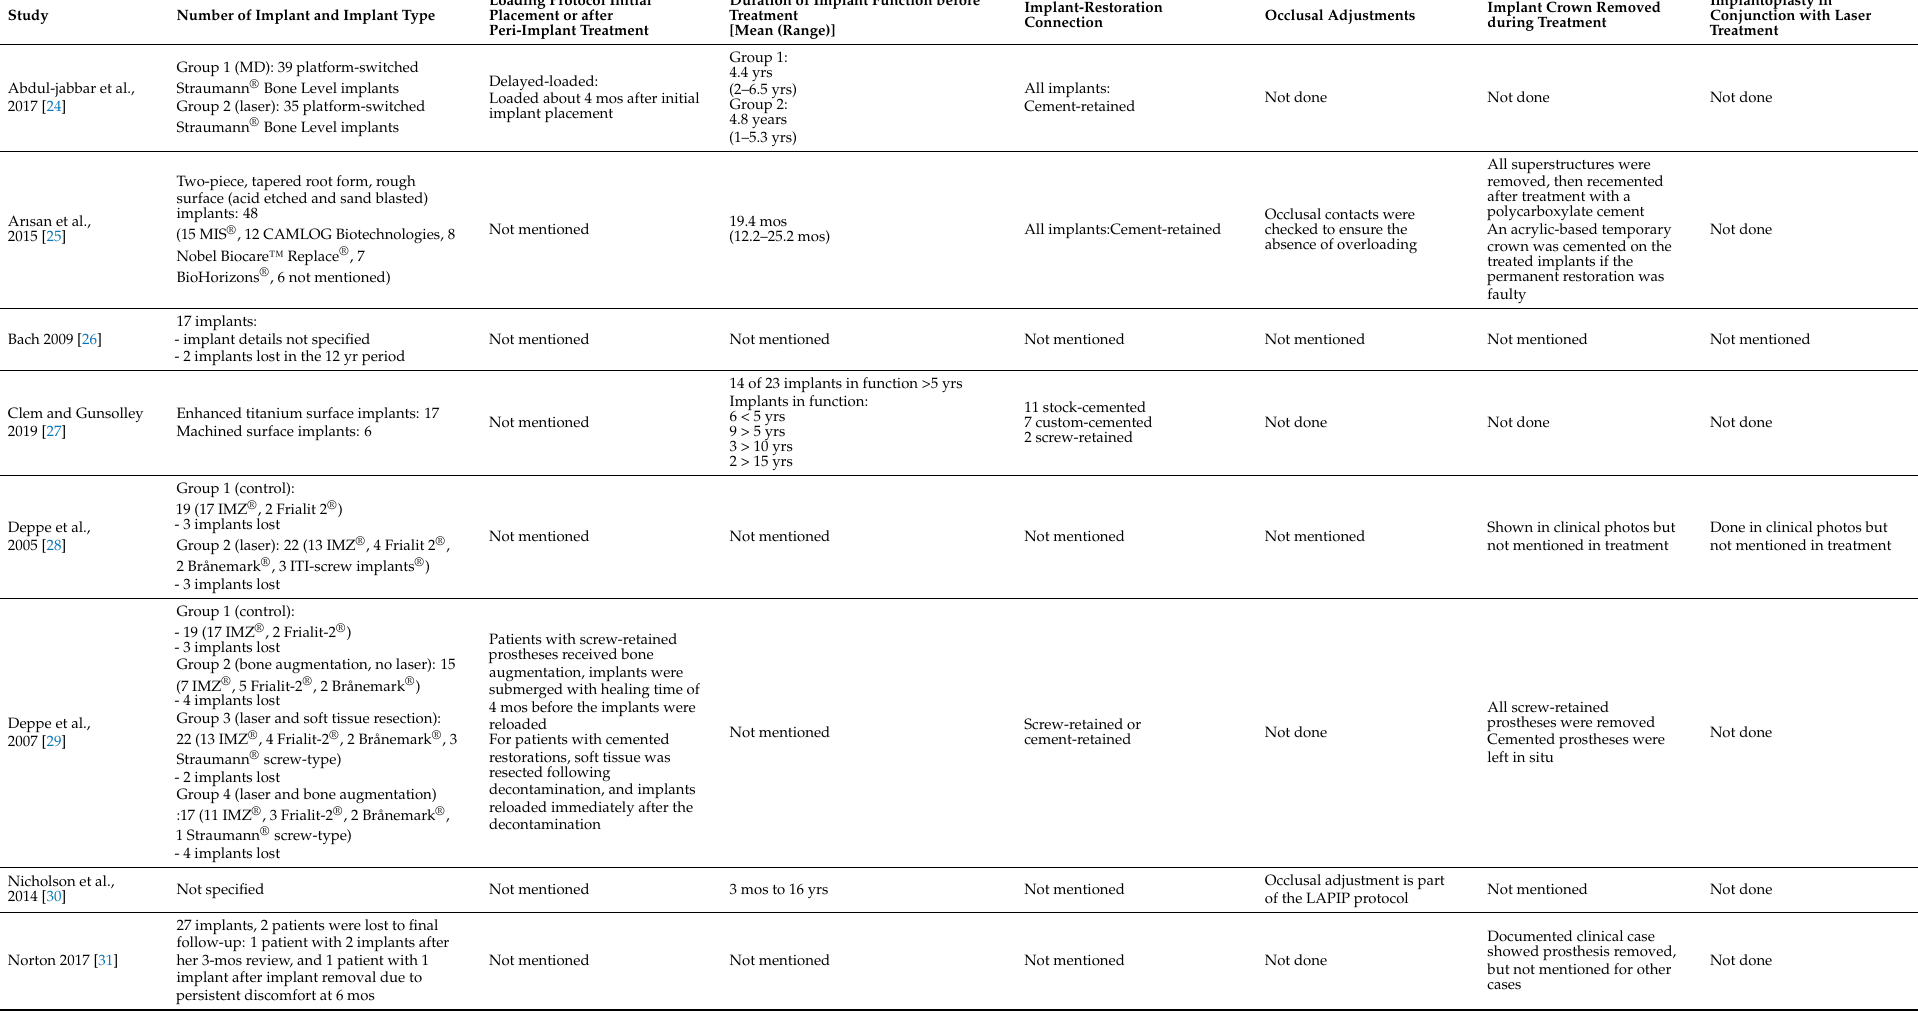
Table 5. Implant details and restorative